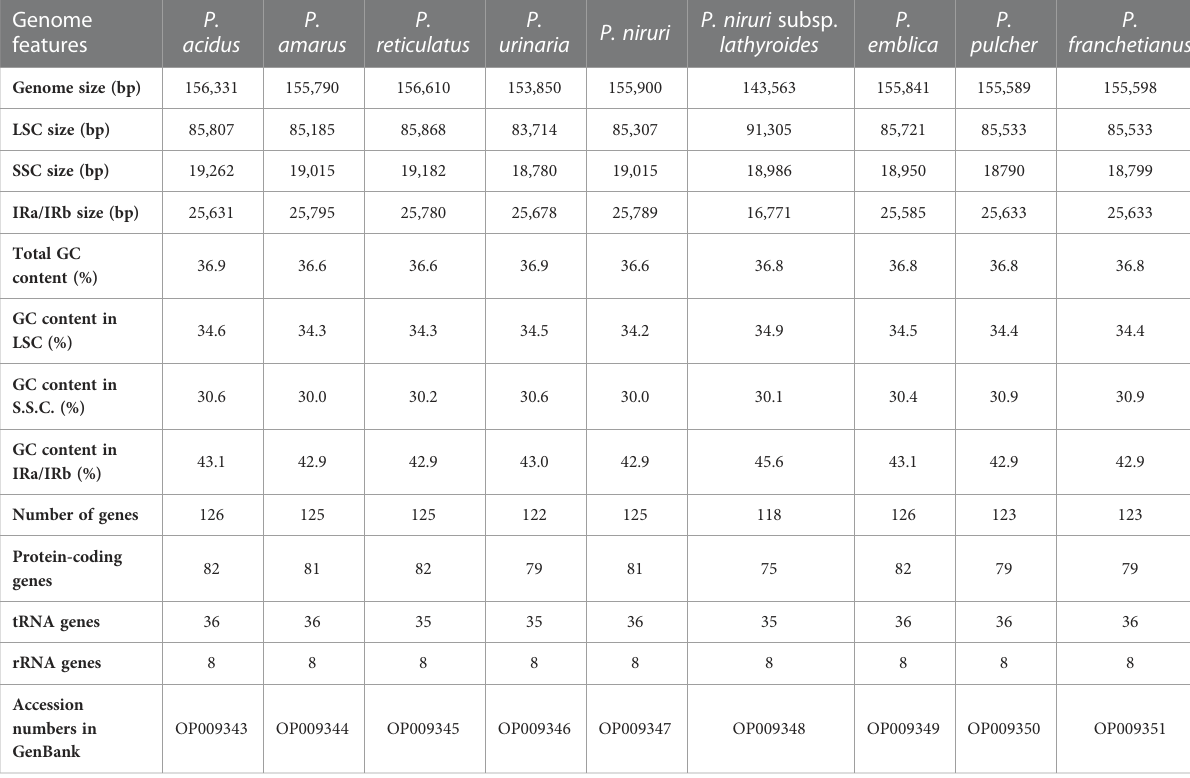
TABLE 1 Cp genomes features of nine species of Phyllanthus